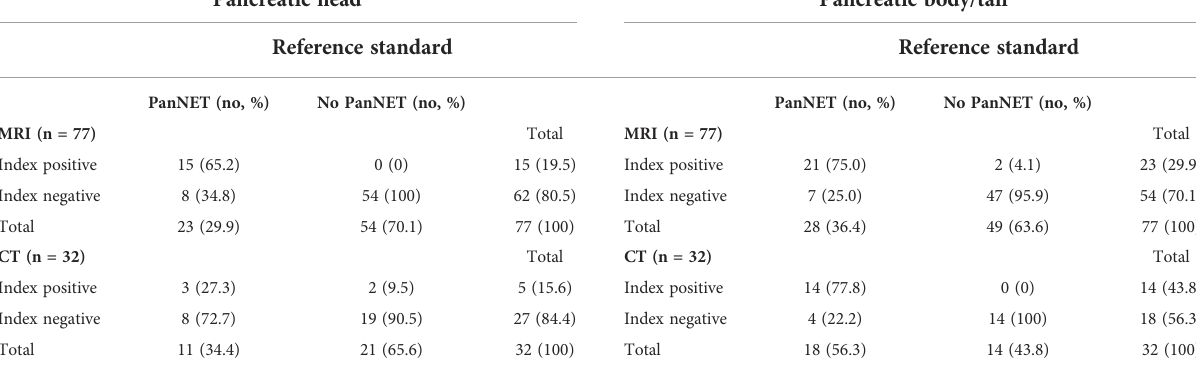
TABLE 3 Contingency tables of MRI and CT as fi rst imaging study in 2010 –